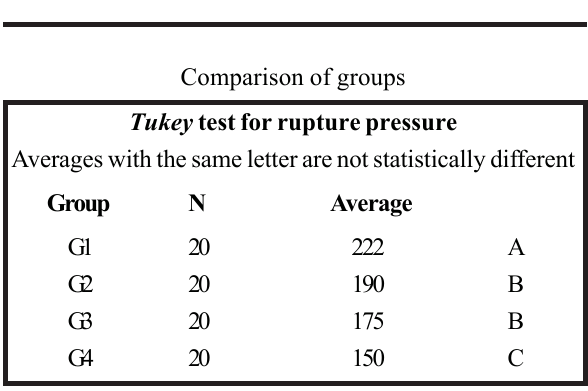
FIGURE 10 - “Box-Plot” of the rupture pressure by liquid distension (mmHg) by groups and